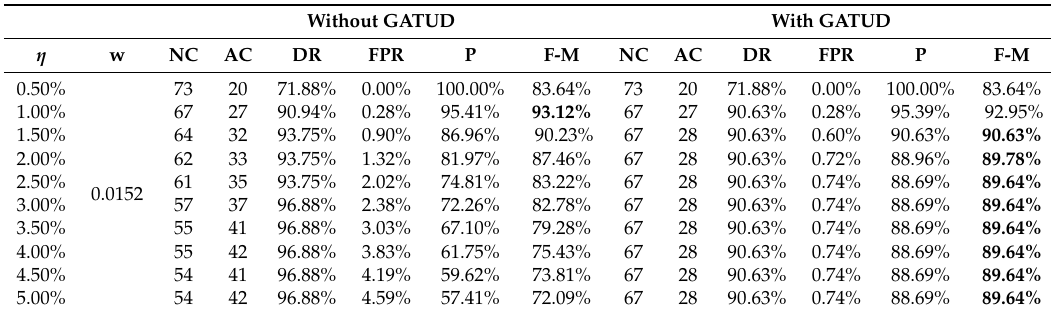
Table 13. The detection accuracy of the proximity-detection rules that have been extracted with/without the integration of GATUD in the separation process on